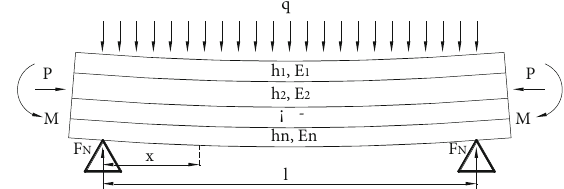
Figure 1: Hierarchical mechanical analysis chart of two-end simple support